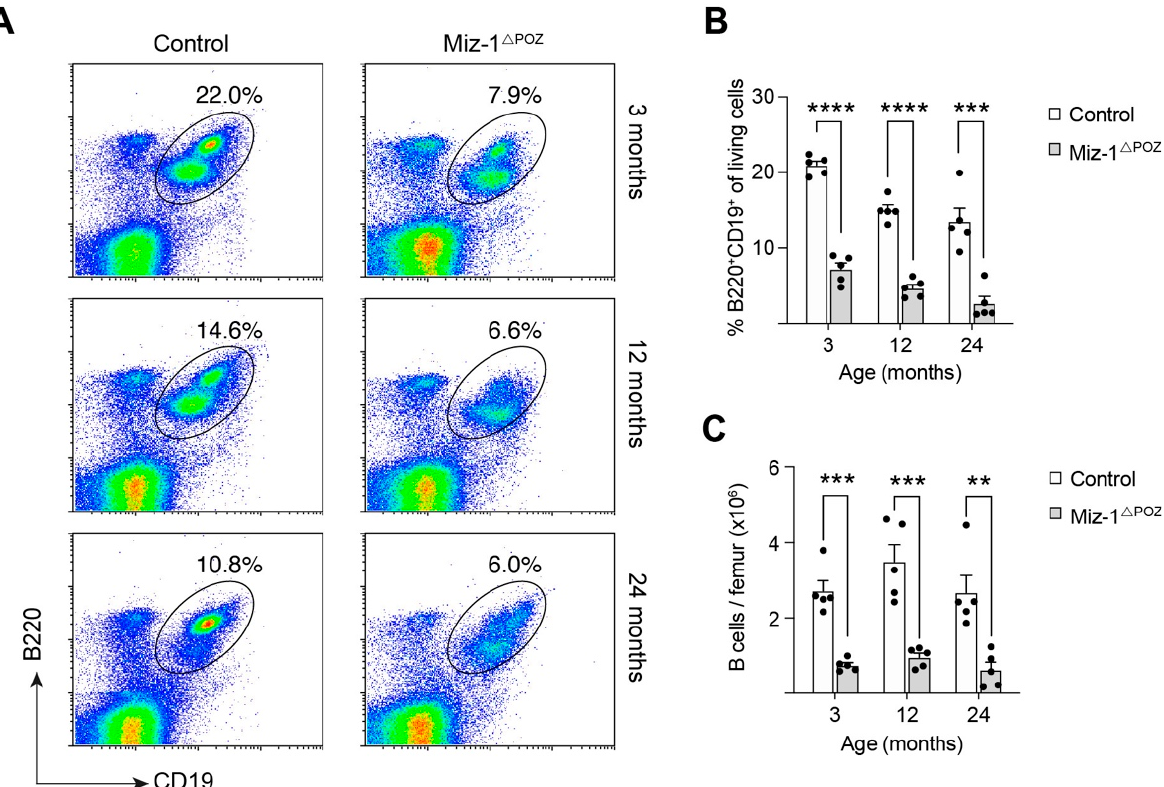
Figure 1. Age-related decline in bone marrow B cells. ( A ) Flow cytometric analysis of bone marrow cells from control and Miz-1 ∆ POZ mice. Cells were analyzed with antibodies for B220 and CD19. Cells are pre-gated for debris and doublet exclusion. Percentages in dot plots are given for the respective gates. ( B ) Frequency of B cells (B220 + CD19 + ) from bone marrow of control and Miz-1 ∆ POZ mice. ( C ) Quantification B cells (B220 + CD19 + ) from bone marrow of control and Miz-1 ∆ POZ mice, corrected to the number of living cells. One point represents one mouse. Data are expressed